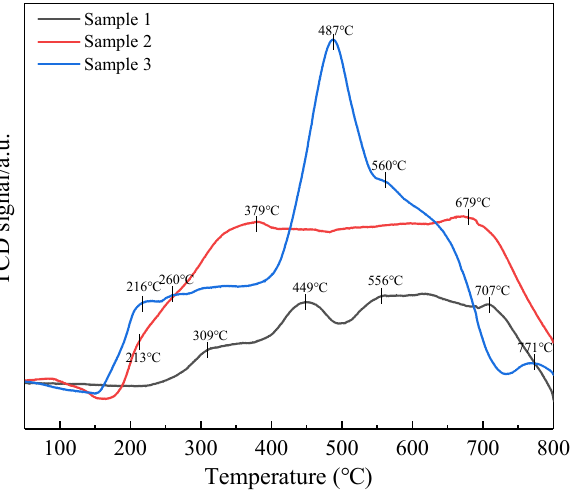
Figure 6. NO-TPD of the catalyst before and after